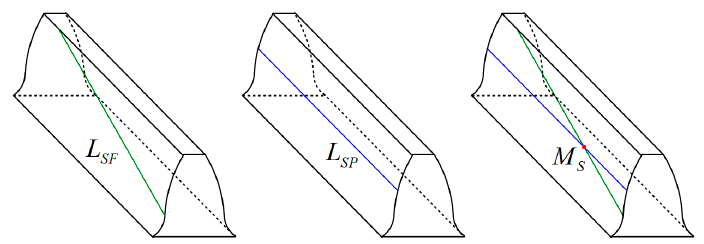
Figure 6. Instantaneous meshing lines on the shaper.